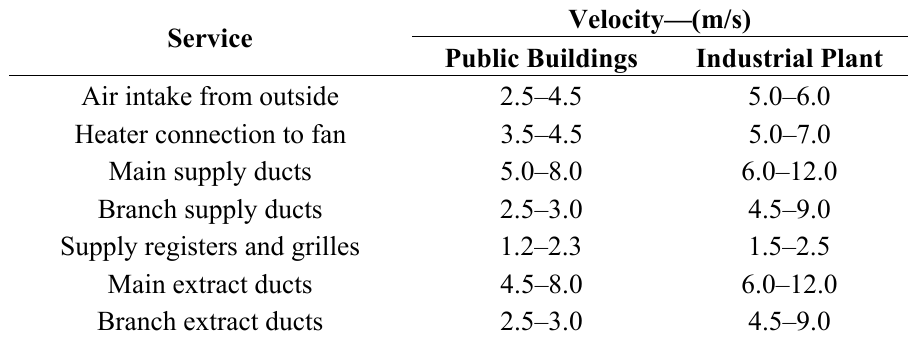
Table 2. Air velocities in air conditioning and ventilation